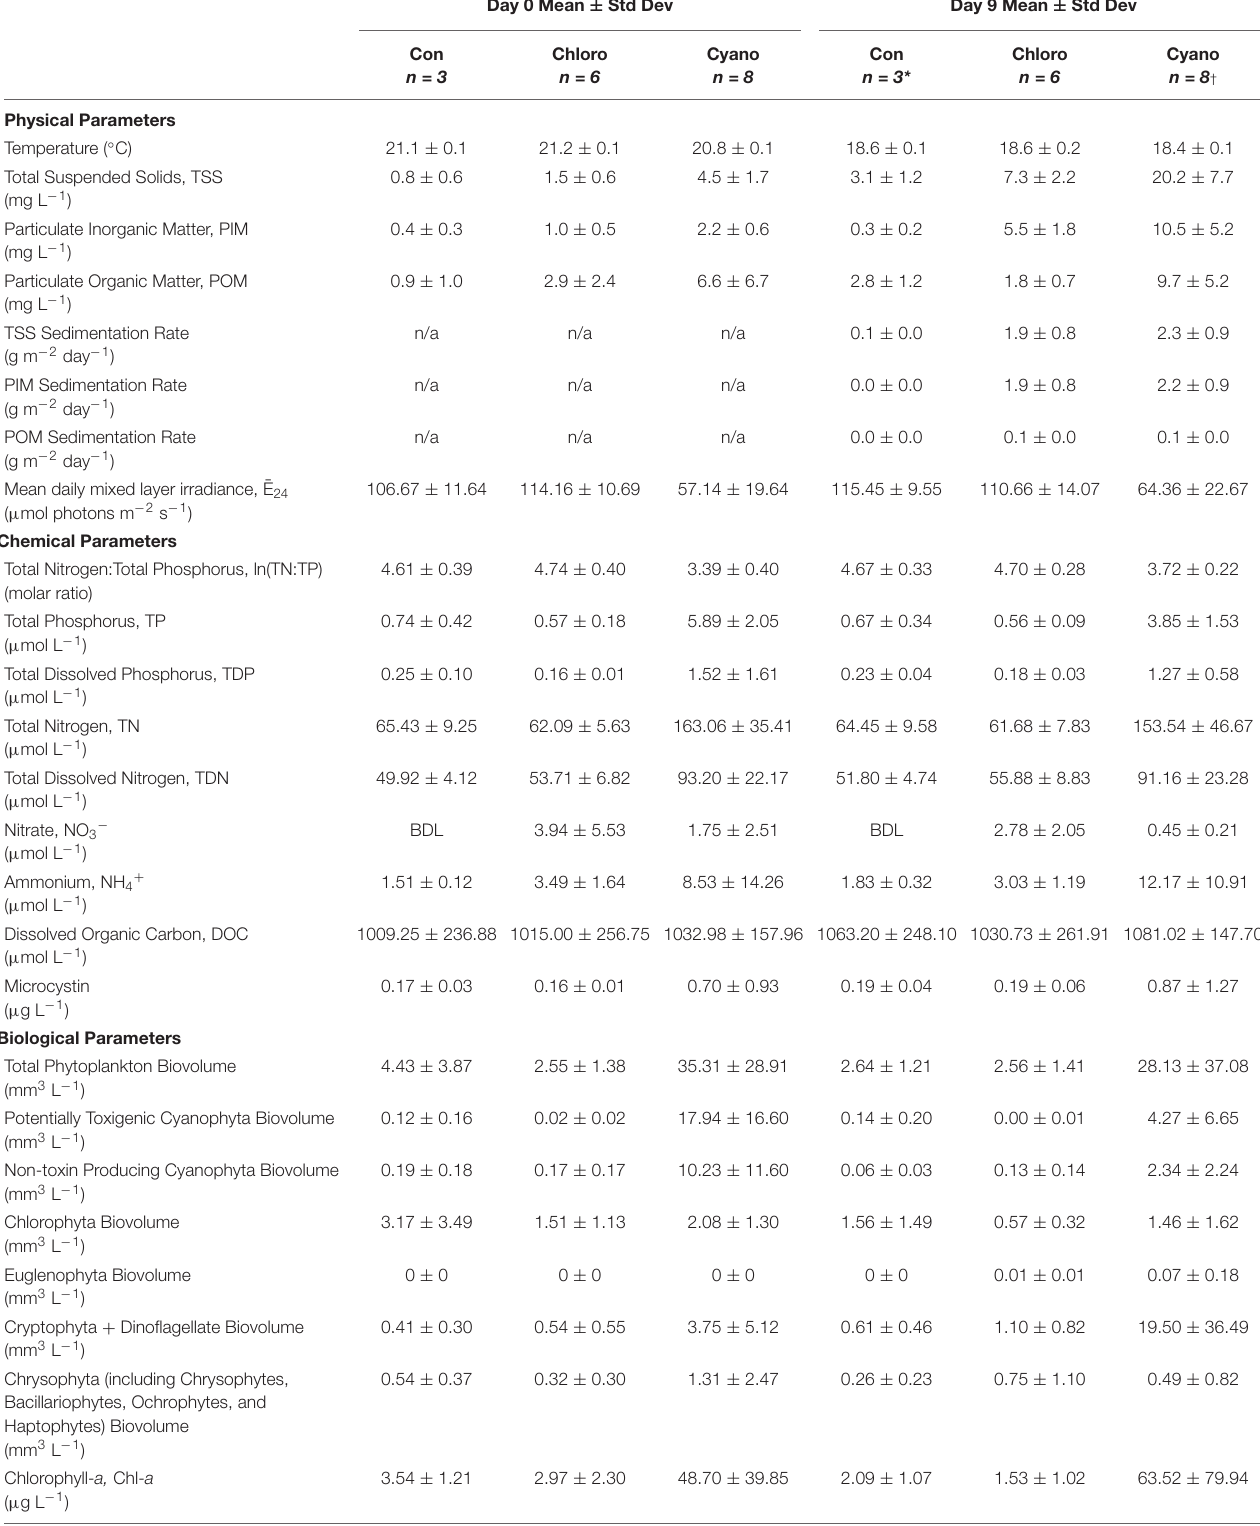
TABLE 3 | Water quality and phytoplankton physiology parameters. Control (Con), chlorophyte- (Chloro), and cyanophyte- (Cyano) dominated mesocosm tanks prior to glacial rock flour addition (day 0) and at the end of the experiment (day